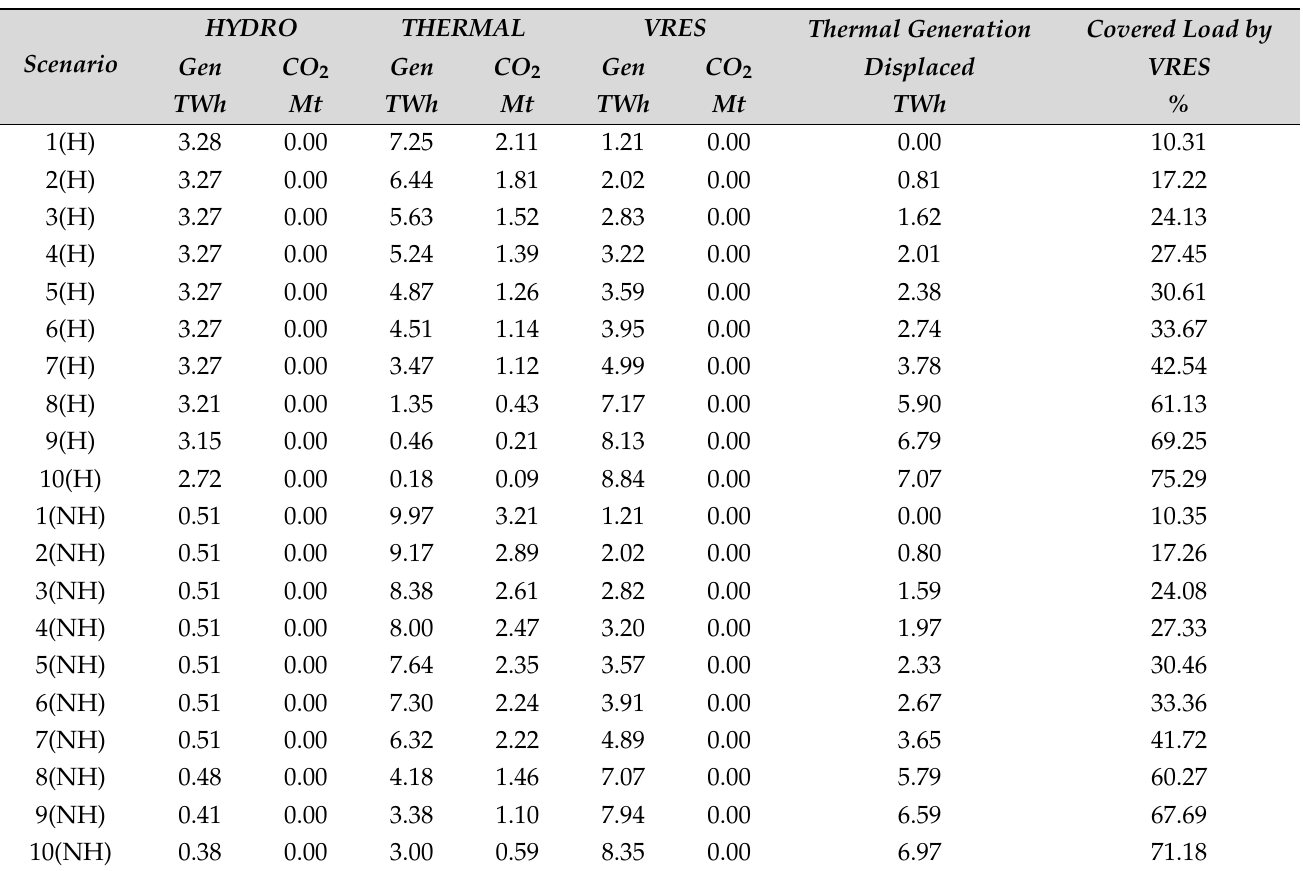
Table 8. Generation results for each